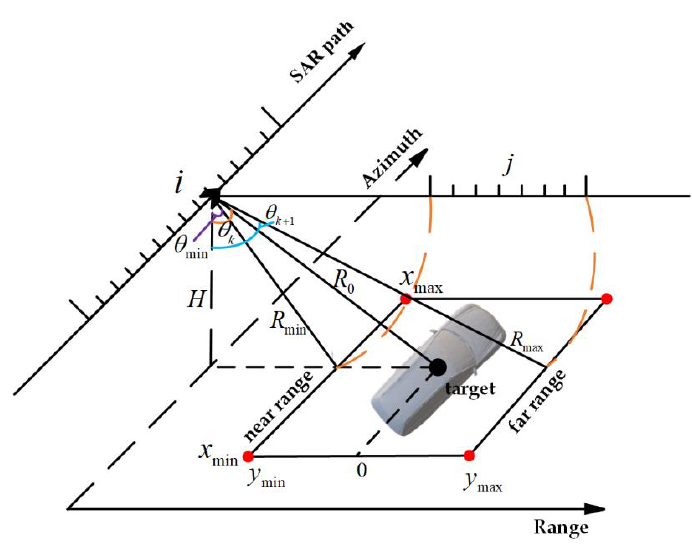
Figure 2. Geometric relationship of the lattice model.